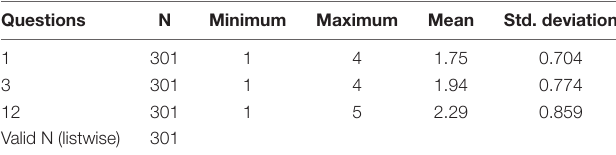
TABLE 9 | Descriptive statistics of the questions related to the learners’ autonomy in technology-integrated classrooms.